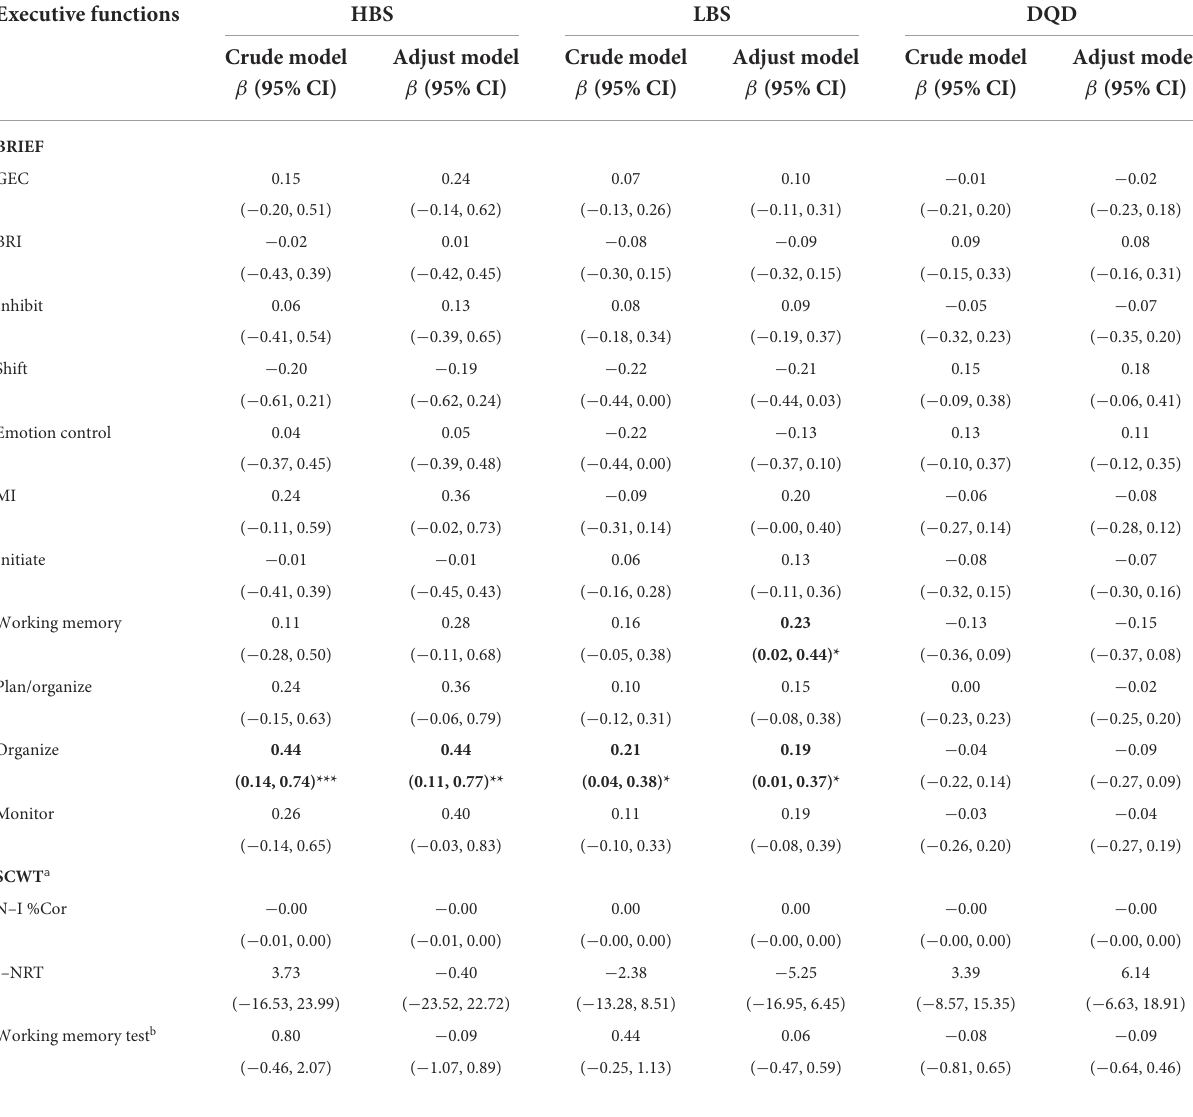
TABLE 2 The association of DBI_16 indicators with executive functions in children with ASD. Executive